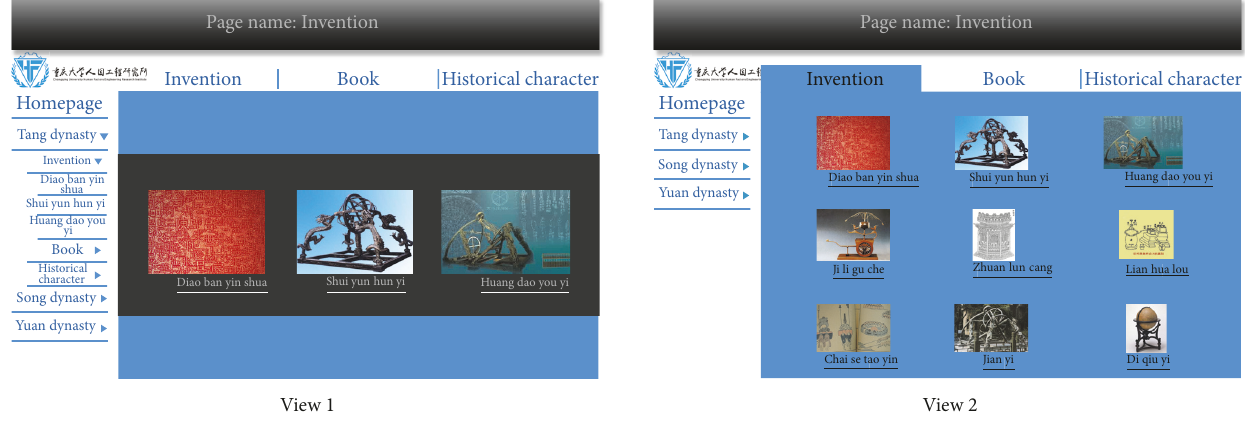
Figure 2: Two views of web page interfaces in this experiment.